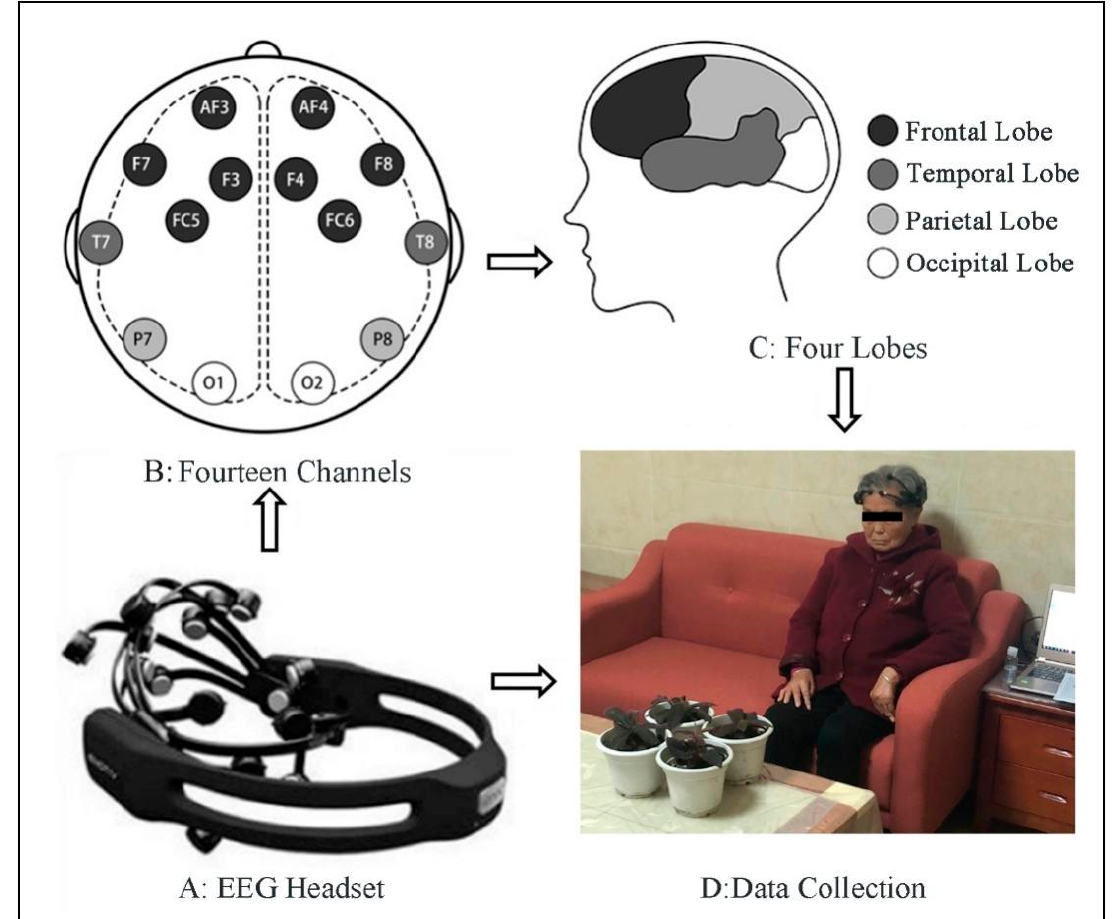
Figure 2. EEG Data Collection.